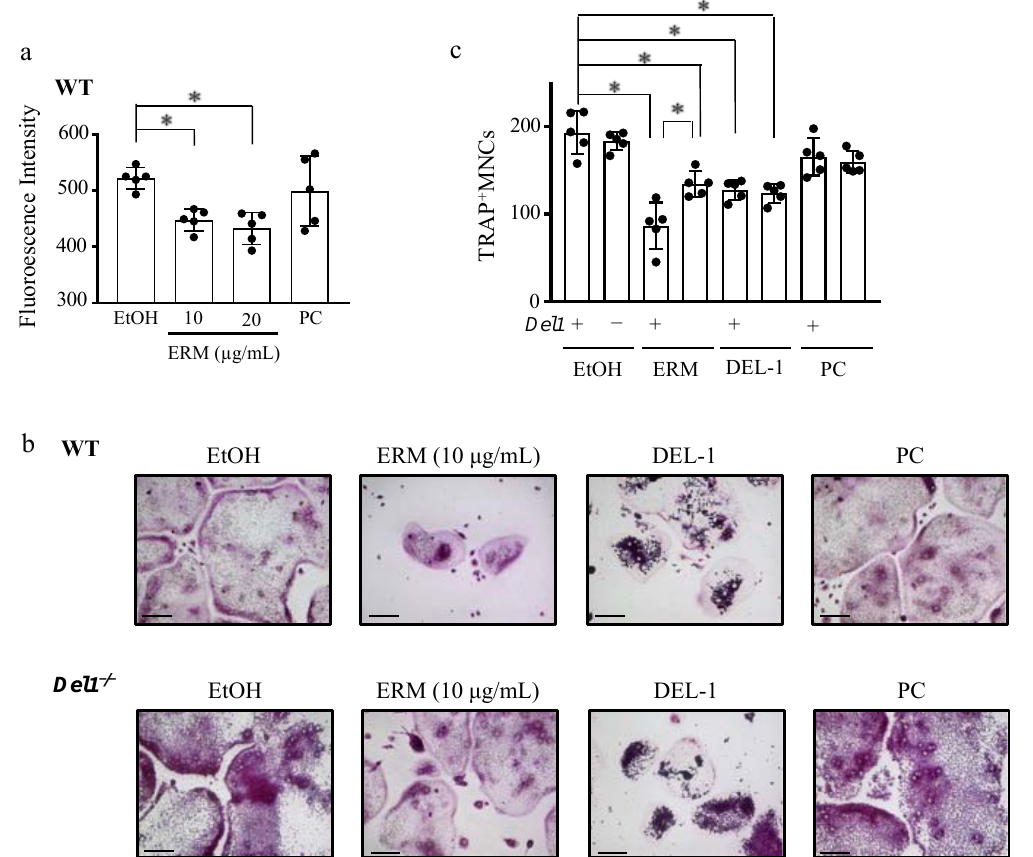
Figure 7. Erythromycin suppresses osteoclast differentiation in vitro in a DEL-1-dependent manner in wild-type mice. RANKL-induced osteoclastogenesis and bone resorption activity were determined in wild-type (WT) or Del1 -/- mouse bone marrow-derived osteoclast precursors in the presence of ethanol (EtOH; control), erythromycin (ERM; 10, 20 µg/mL), penicillin (PC; 5 units/mL), and DEL-1-Fc (DEL-1; 5 µg/mL). ( a ) Osteoclasts were cultured on a fluoresceinamine-labeled sodium chondroitin poly-sulfate/calcium phosphate (FACPS/CaP)-coated plate, and the absorption activity was examined by measuring the fluorescence intensity of the culture supernatant. ( b ) Representative images of TRAP + osteoclasts obtained by optical microscopy are shown. Scale bars, 100 µm. ( c ) Cells were stained for tartrate-resistant acid phosphatase (TRAP) to detect osteoclasts, and TRAP-reactive MNCs were counted. * p < 0.05, compared to the indicated group, means ± SD ( n = 5 per group).